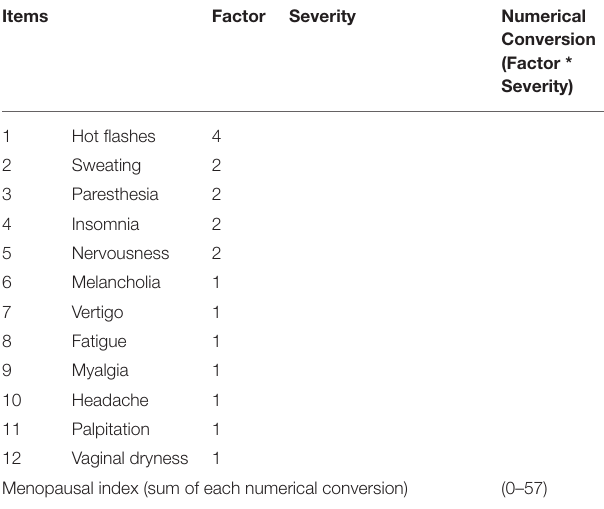
TABLE 1 | The Kupperman